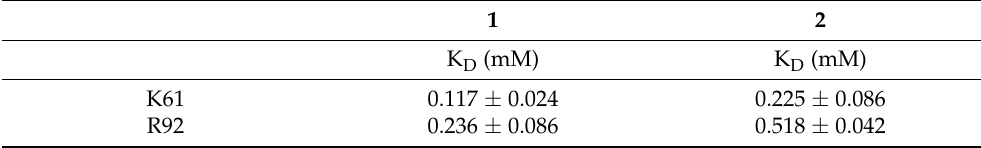
Table 1. K D and σ K D of K61 and